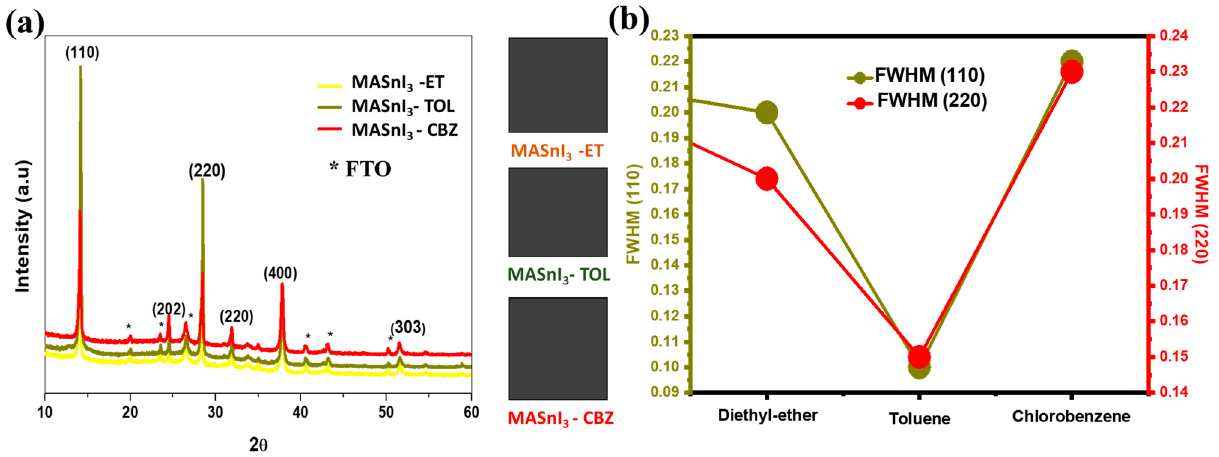
Figure 1. ( a ) XRD patterns of MASnI 3 films treated with toluene, chlorobenzene, and diethyl ether ( b ) FWHM of MASnI 3 films treated with toluene, chlorobenzene, and diethyl ether. Lattice